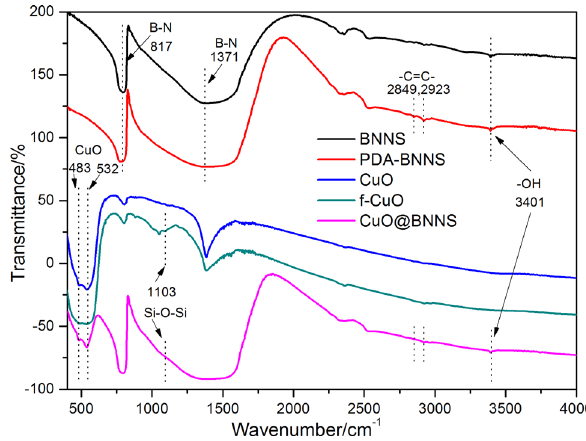
Fig.4 XRD analysis of h-BN, PDA-BNNS, f-CuO and